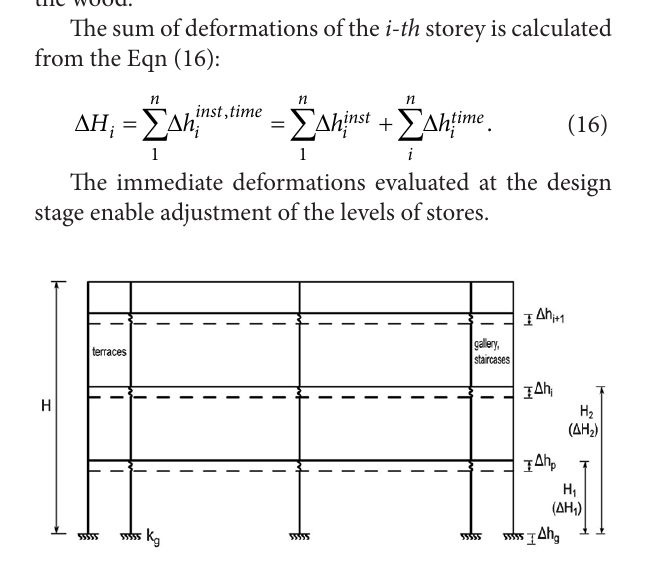
Figure 8. Growth of components